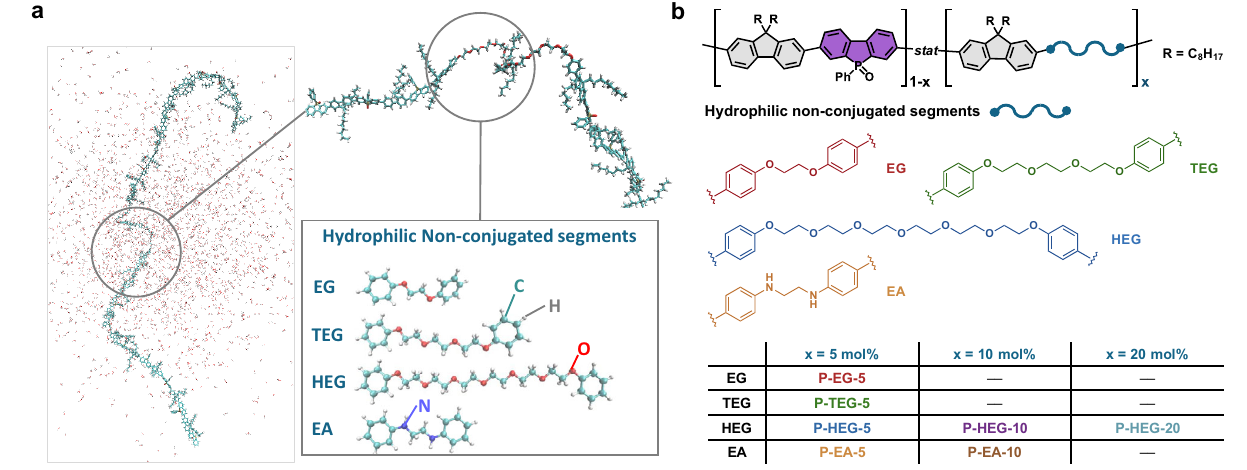
Fig. 1 | Schematic illustration of design strategy and polymer structures. a Schematic illustration of the polymer photocatalysts containing hydrophilic